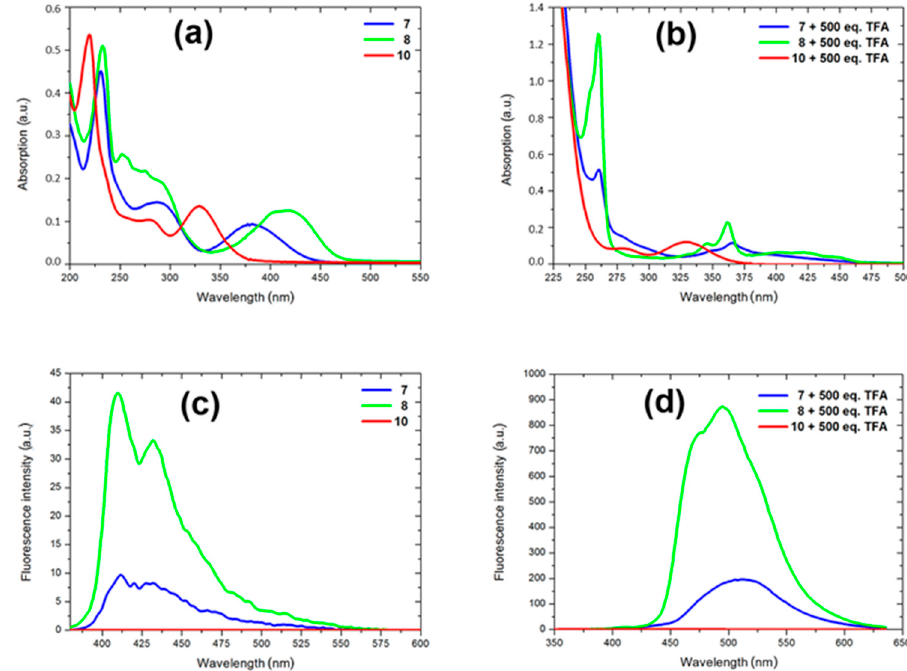
Figure 1. Absorption ( a ) and fluorescence ( c ) spectra of compounds ( 7 ) (blue), ( 8 ) (green), and ( 10 ) (red) in the absence of TFAin MeCN; absorption ( b ) and fluorescence ( d ) spectra after the addition of 500 eq. of TFA. Standardized compound concentration of 10 − 5 mol/L in MeCN.